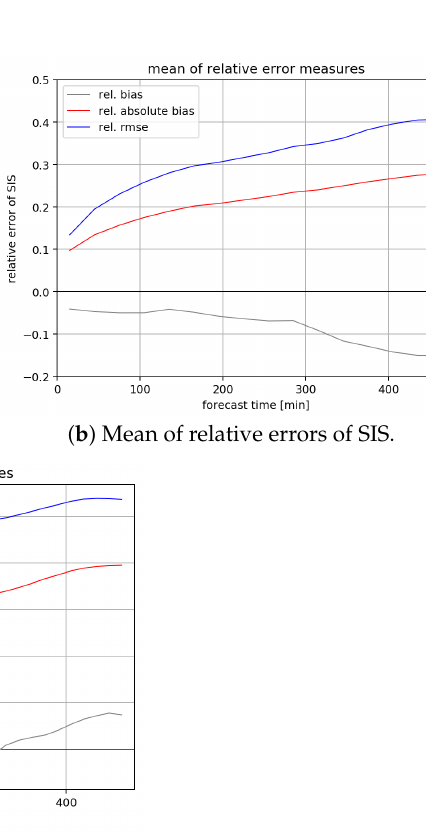
Figure 3. Validation of the solar surface irradiation nowcasting with SARAH-2 data for 29 August 2017 ( a ) and 30 September 2017 ( b ). Depicted is the absolute difference between the SIS nowcasting and the SARAH-2 data set for a 255 min forecast.